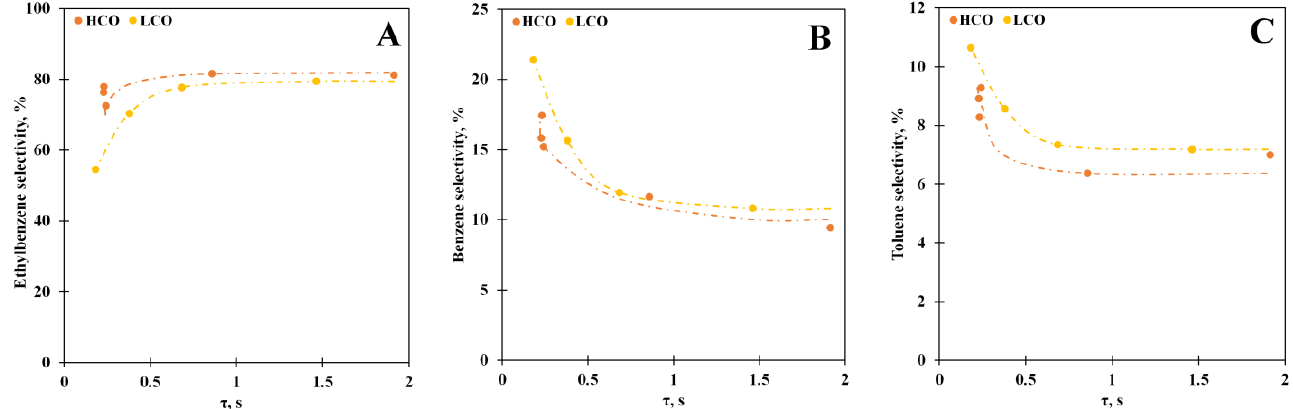
Figure 6. The ethylbenzene ( A ), benzene ( B ), and toluene ( C ) selectivity vs. the vapor residence time for the PS solutions in LCO (15% PS) and HCO (10% PS) at 550 °C .